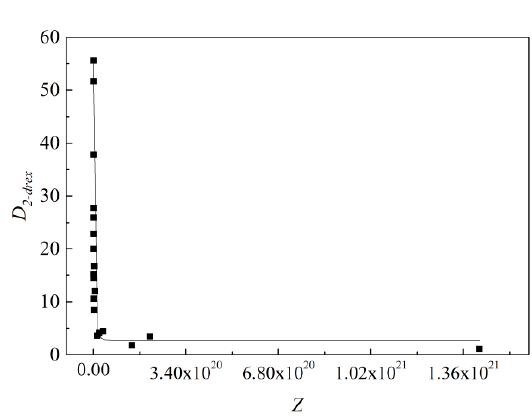
Figure 10. D 2-drex and Z fitted image.